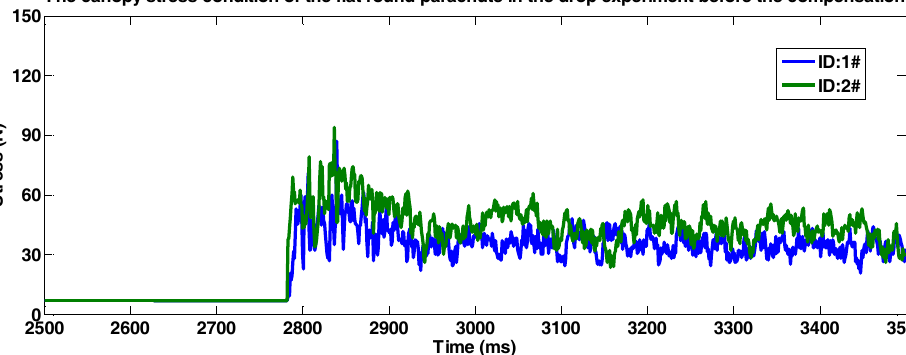
Figure 6. The canopy stress condition of the flat round parachute before the compensation.